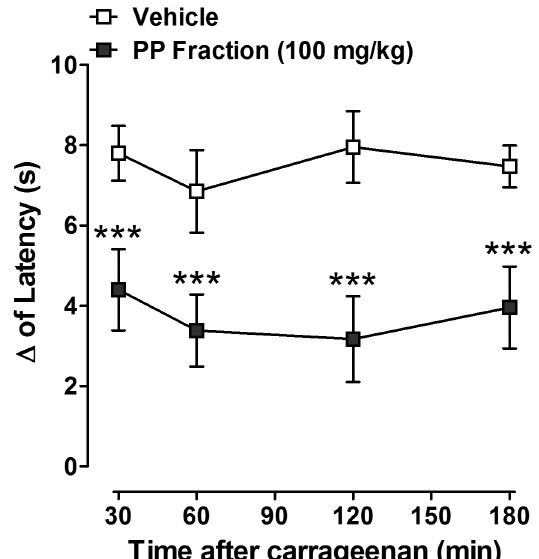
Figure 3 - Effect of PPAC fraction (100 mg/kg; po) on carrageenan-induced rat paw edema. Each point represents the mean ± SEM of 7–10 animals. ***p<0.001 in a two- way ANOVA Bonfer roni